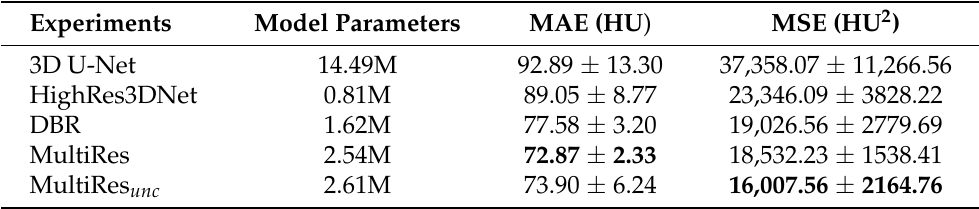
Table 1. Mean Absolute Error (MAE) and Mean Squared Error (MSE) across all experiments on the whole-body dataset including number of trainable variables. Bolded entries denote best model ( p -value < 0.05).